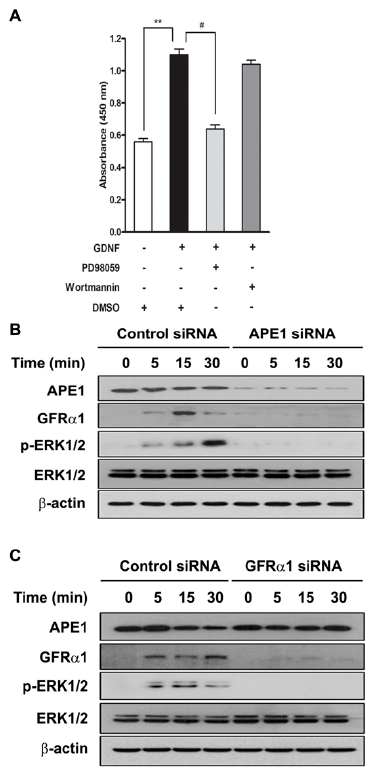
Figure 2. APE1 and GFR α 1 increases ERK phosphorylation in response to GDNF. ( A ) MIA PaCa-2 cells were pretreated with MEK-1 inhibitor PD98059 (10 µ M) and the PI3K inhibitor Wortmannin (200 µ M) and then treated with or without 50 ng / mL GDNF for 24 h. After treatment, cell proliferation was analyzed by WST-1 assay. Data are expressed as mean ± standard deviation from three independent experiments. ** and # denote p < 0.01 by t -test for equality of means. ( B and C ) MIA PaCa-2 cells were transfected with APE1 siRNA ( B ) or GFR α 1 siRNA ( C ) and incubated with GDNF (50 ng / mL). Cells were lysed at the indicated times and subjected to immunoblotting with indicated